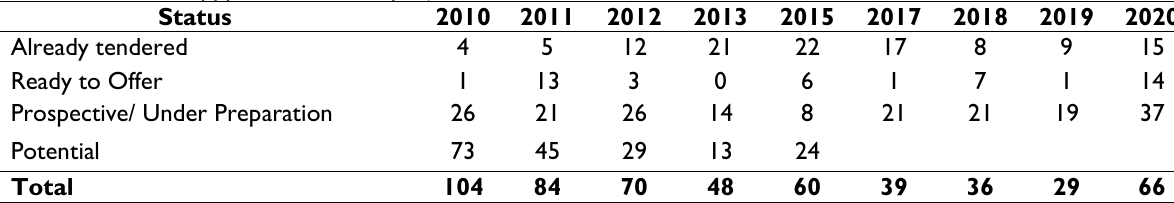
Table 1. Number of ppp infrastructure projects in indonesia